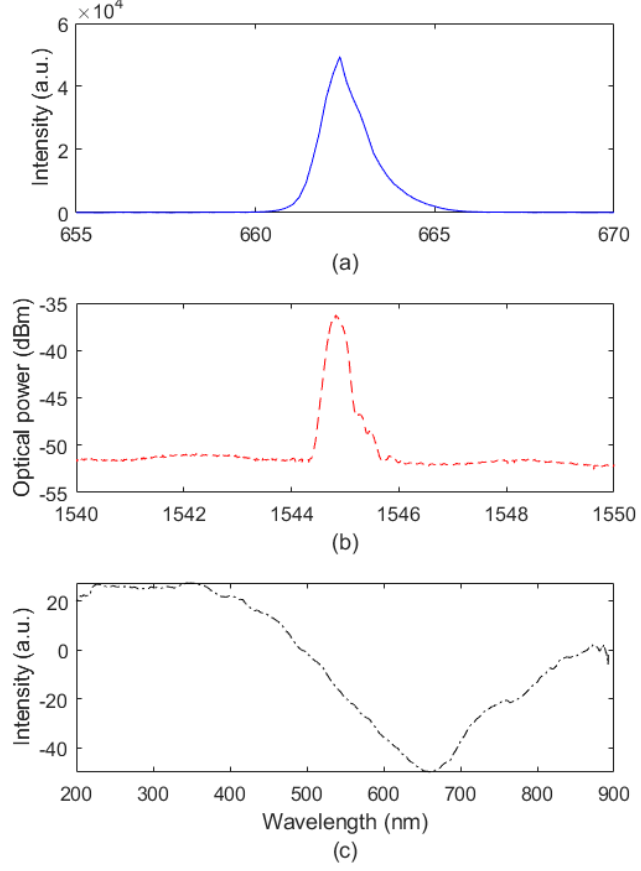
Figure 2. Transmitted/reflected spectrum for ( a ) intensity, ( b ) FBG, and ( c ) SPR.